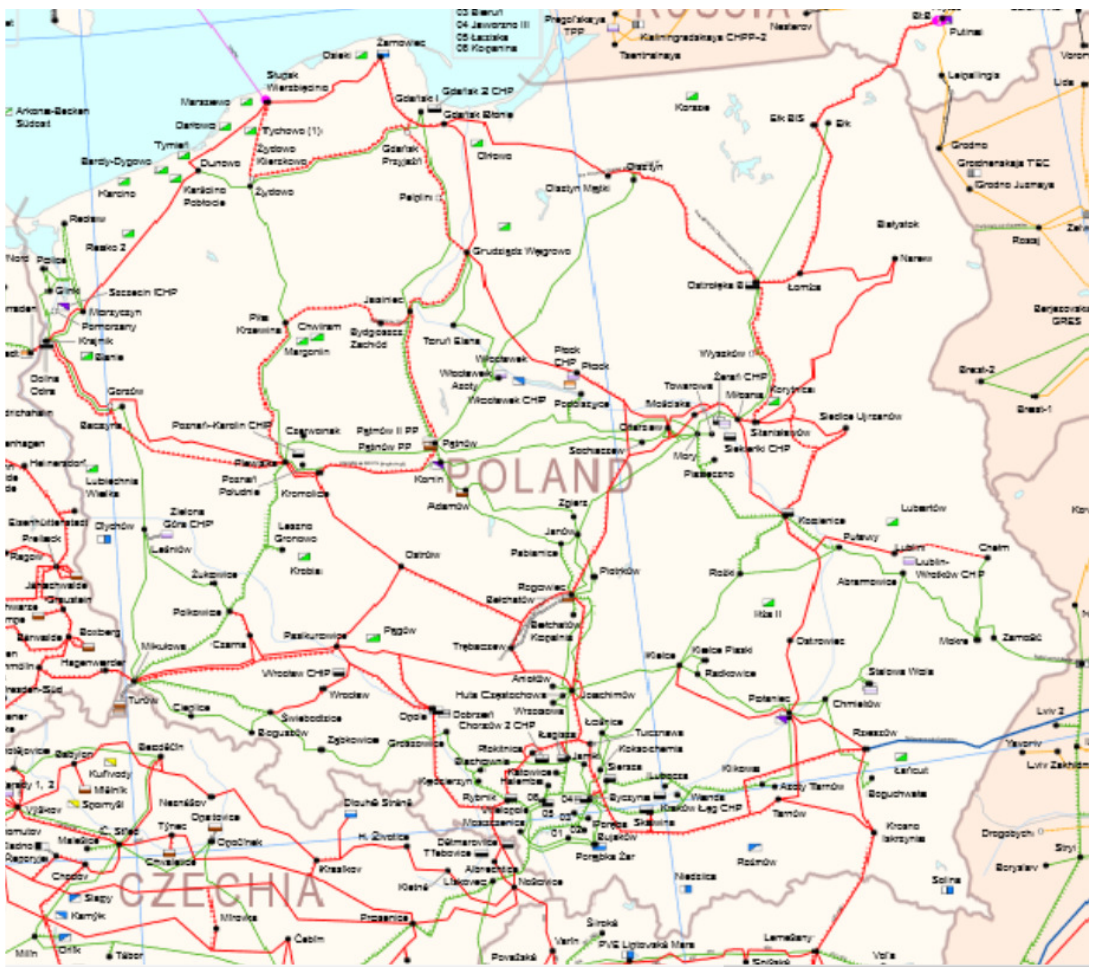
Figure 1. Map of the Polish National System of high voltage lines by the European Network of Transmission System Operators for Electricity, where the blue line marks 750 kV line, red 380–400 kV, yellow 300–330 kV and green 220–275 kV, the pink line means DC, gray lines are connection lines, and lines intersected by vertical small parallel lines marks two or more circuits. The alternative version of the map (in Polish) can be found here: https://www.pse.pl/web/pse-eng/areas-of-activity/polish-